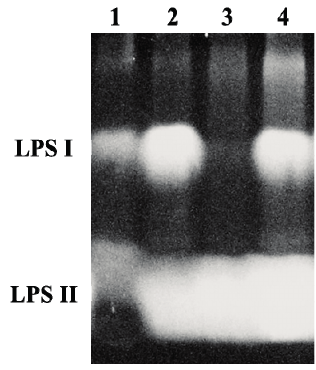
Figure 1. Comparison of hydropathy plots of WaaL proteins from E. coli ( a ); S. enterica serovar Typhimurium ( b ); and B. japonicum 61A101C ( c ). The x- axis represents the amino acid residue position, while the y- axis represents the relative hydrophobicity score. Peaks above the red line indicate potential membrane-spanning domains. Each protein contains 12 potential membrane-spanning domains.